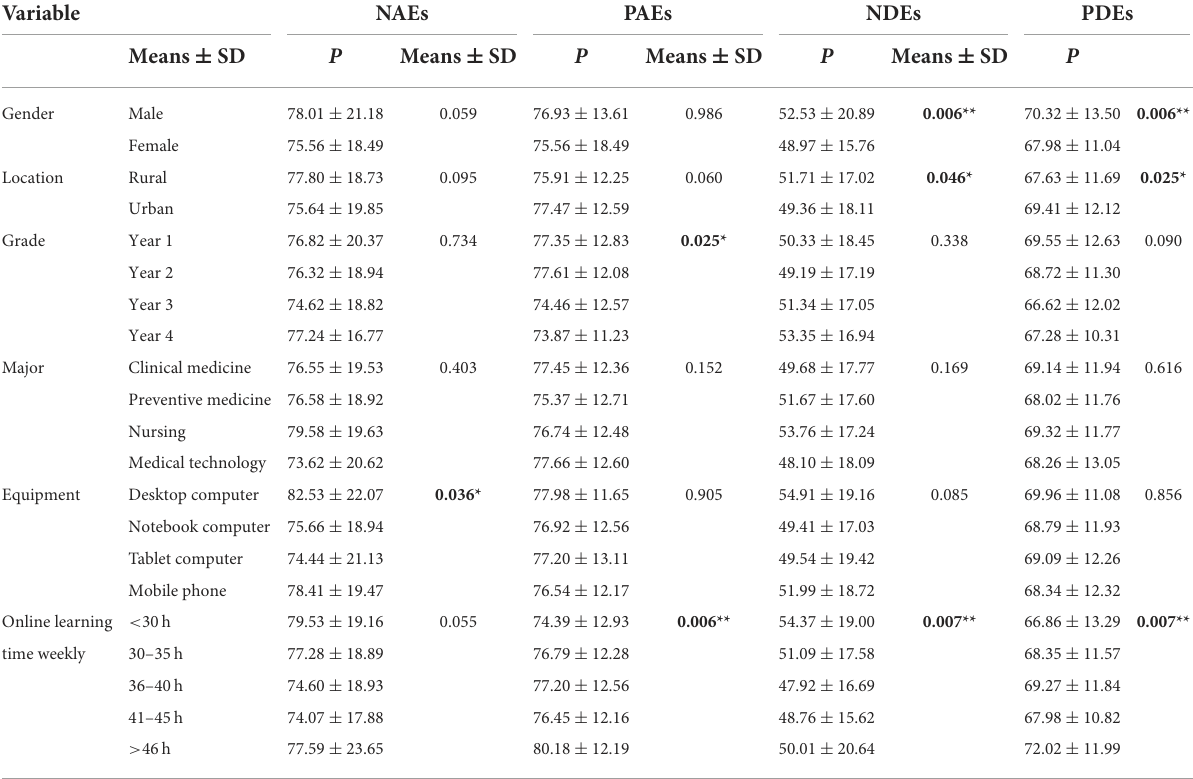
TABLE 2 Results of GAEQ among CMU medical undergraduates under the background of COVID-19.